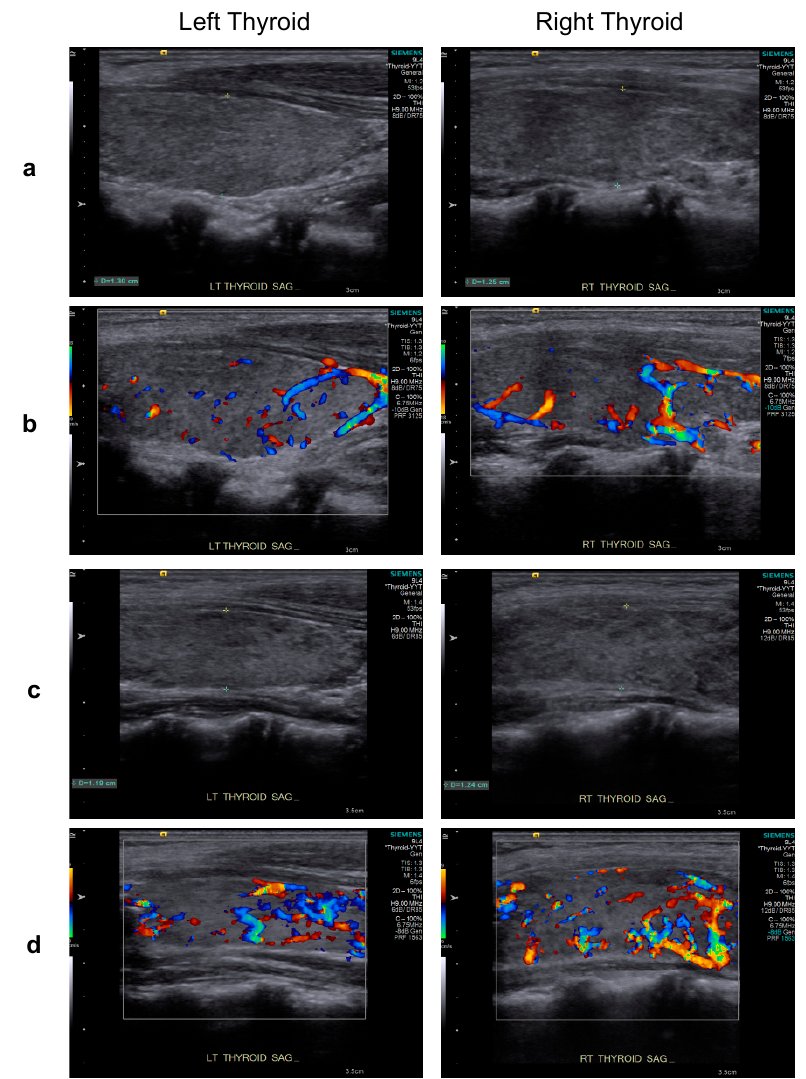
Figure 3. Upon presentation for hyperthyroidism, thyroid sonography of the patient revealed thyroid dimensions at the upper limit of the normal range and mildly heterogeneous parenchymal echotexture (grayscale sagittal images) ( a ) and hyperemia throughout the gland (color Doppler images) ( b ), features characteristic of Graves’ disease. A similar pattern of heterogeneous parenchymal echotexture ( c ) and hyperemia ( d ) were noted after 5 months of carbimazole treatment.